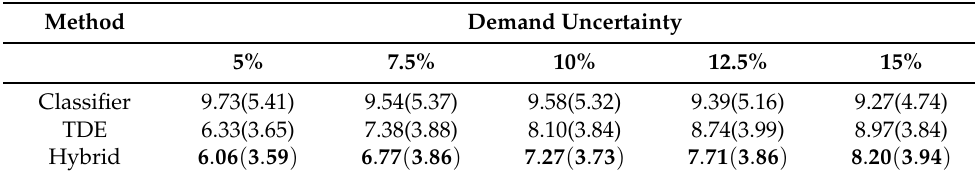
Table 2. Comparing Zone Size in Number of Nodes ZNS ( σ ZNS ) .